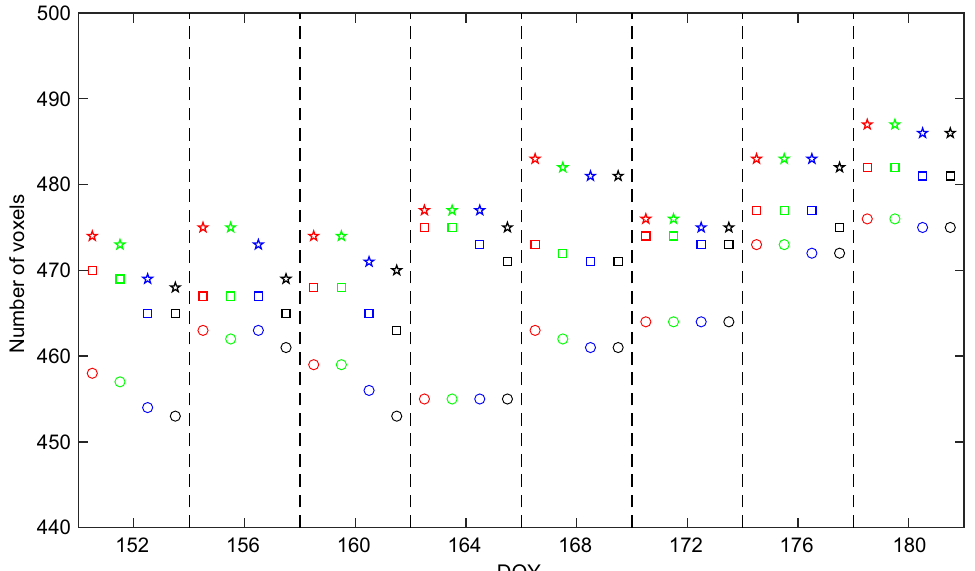
Fig. 3 Number of the voxels passed through by signal rays in each solution for each scheme in the eight selected days (pentagram, square, and circle denote the tomographic window of 30 min, 20 min and 10 min, respectively; red, green, blue, and blank represent the sampling rate of 30 s, 60 s, 150 s and 300 s,